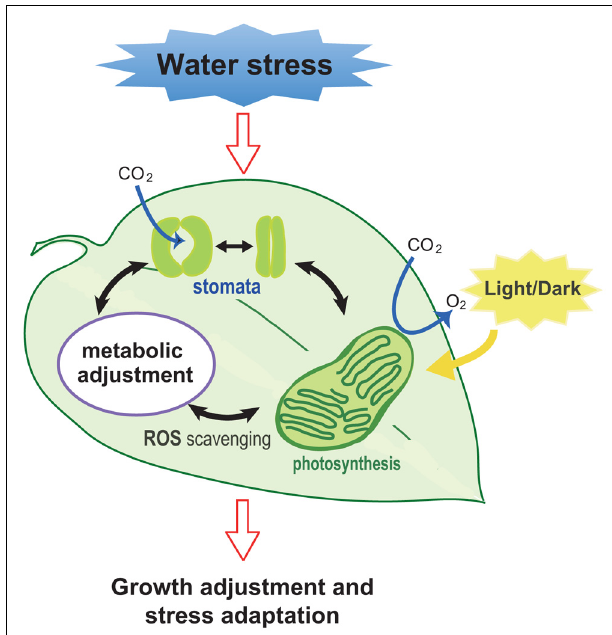
FIGURE 1 | Illustration of the response of plants to water stress. Stomatal response, ROS scavenging, metabolic changes, and photosynthesis are all affected when plants are subjected to water stress. These collective responses lead to an adjustment in the growth rate of plants as an adaptive response for